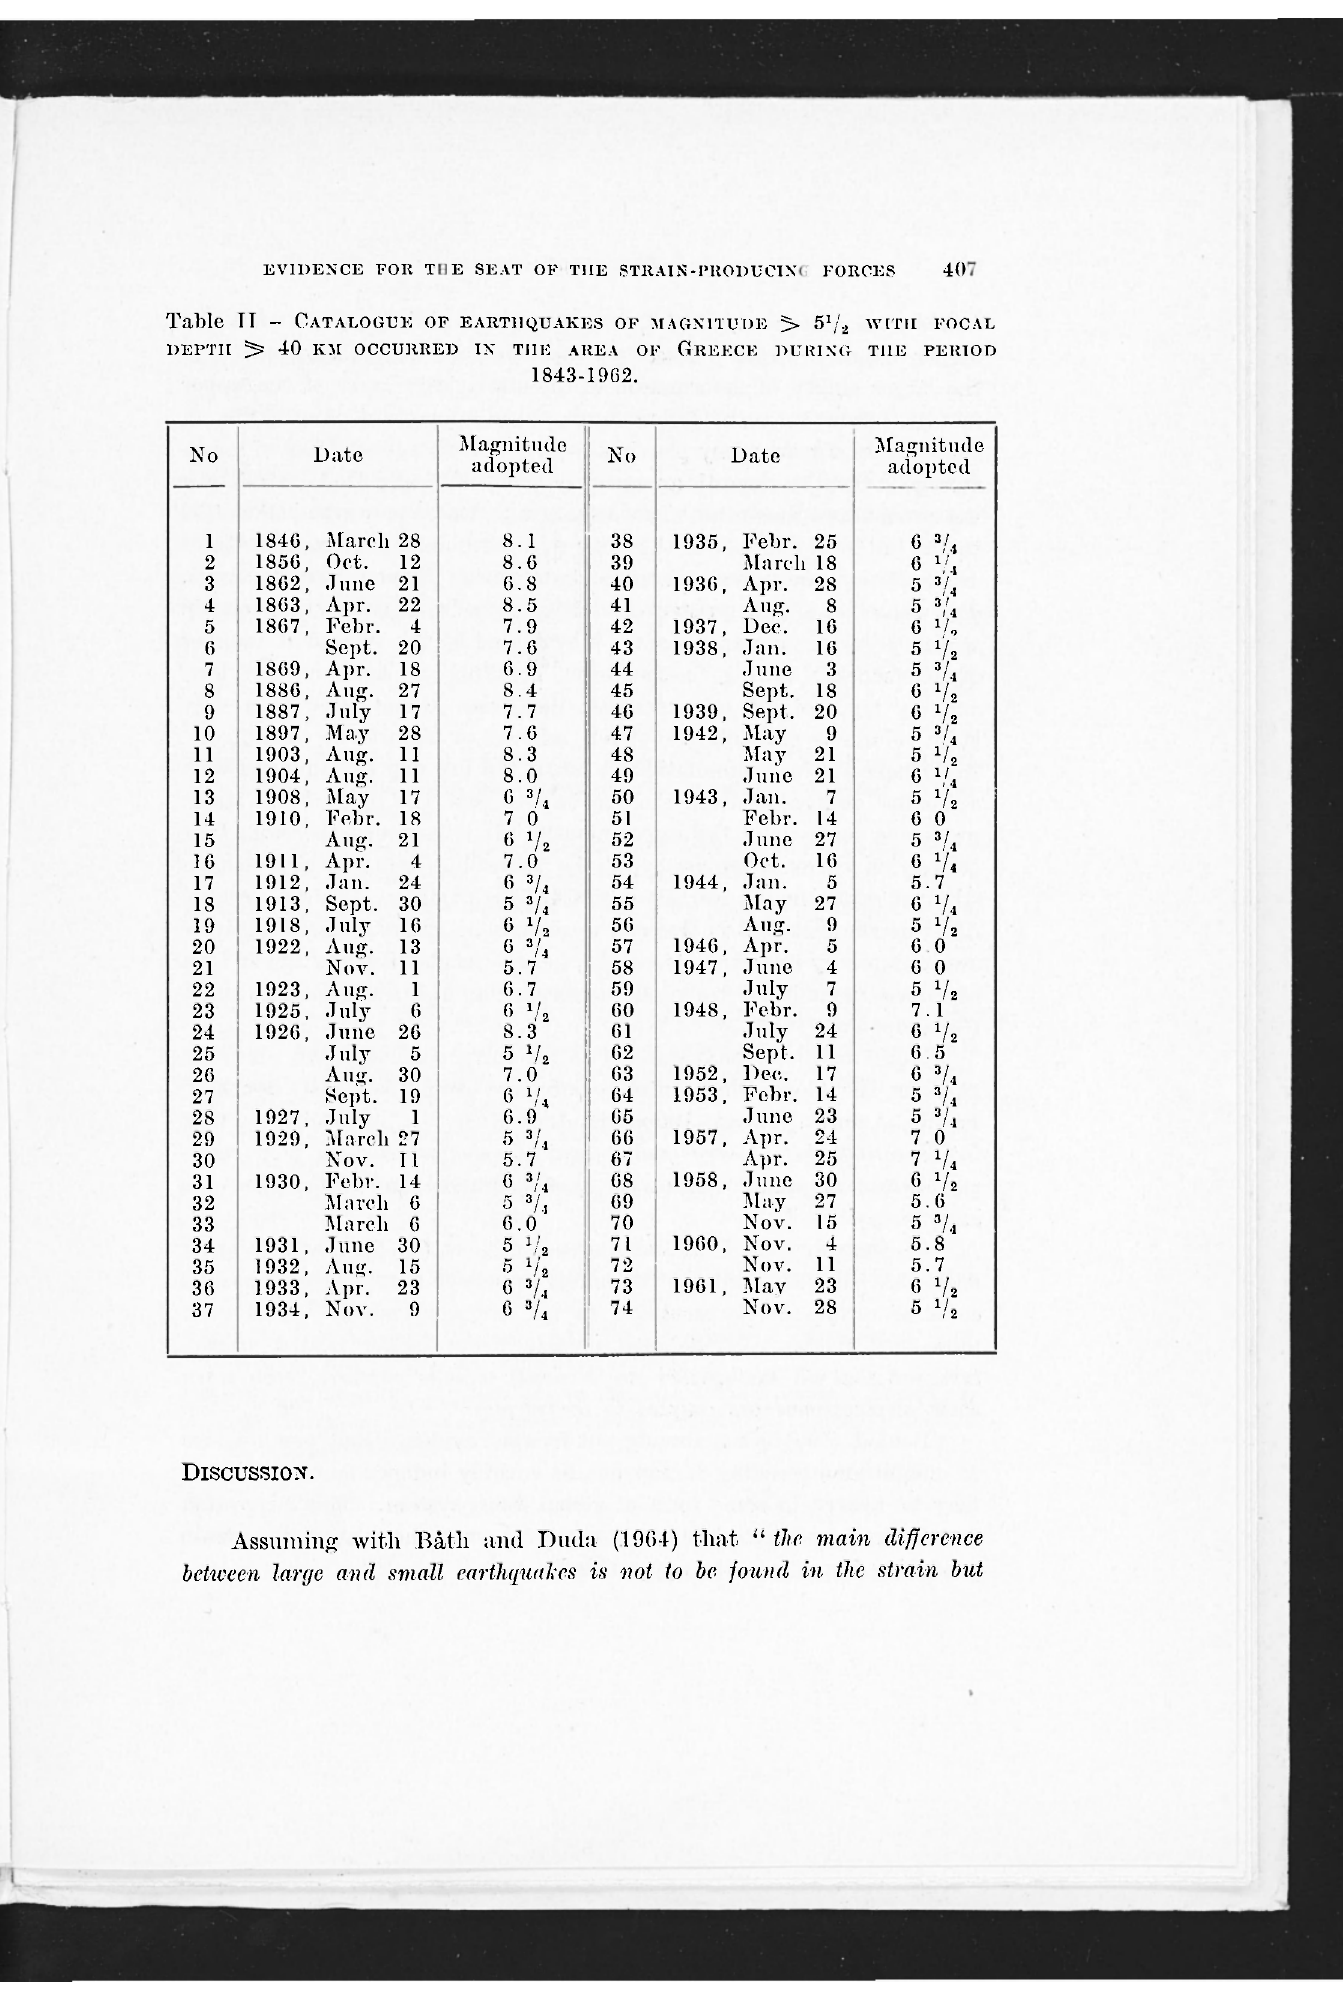
Table II - CATALOGUE OF EARTHQUAKES OF MAGNITUDE 5> 5 1 /